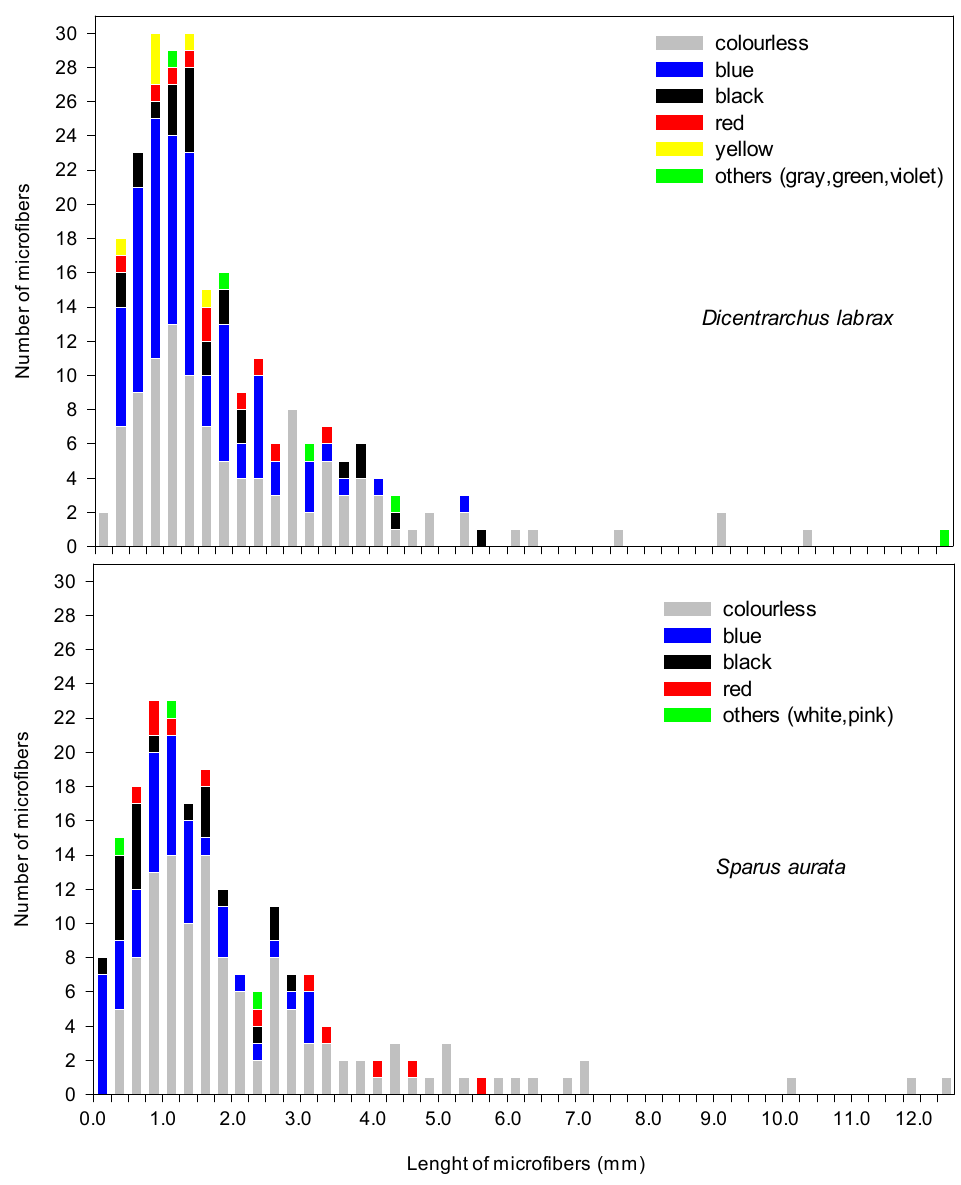
Figure 3. Histogram of size (largest dimension) and colour distribution of the microfibers found in the gastrointestinal tracts of the two species of aquaculture fish evaluated, Dicentrarchus labrax and Sparus aurata ; n = 211–242.